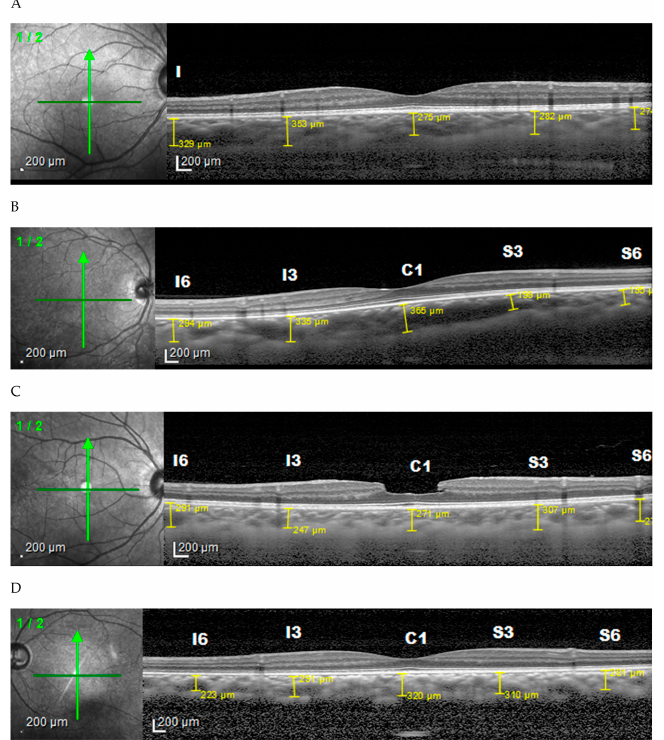
Figure 2. Choroidal thickness based on degrees of myopia vertically. (A) Normal subject (B) Low myopia, (C) Moderate myopia, (D) High myopia